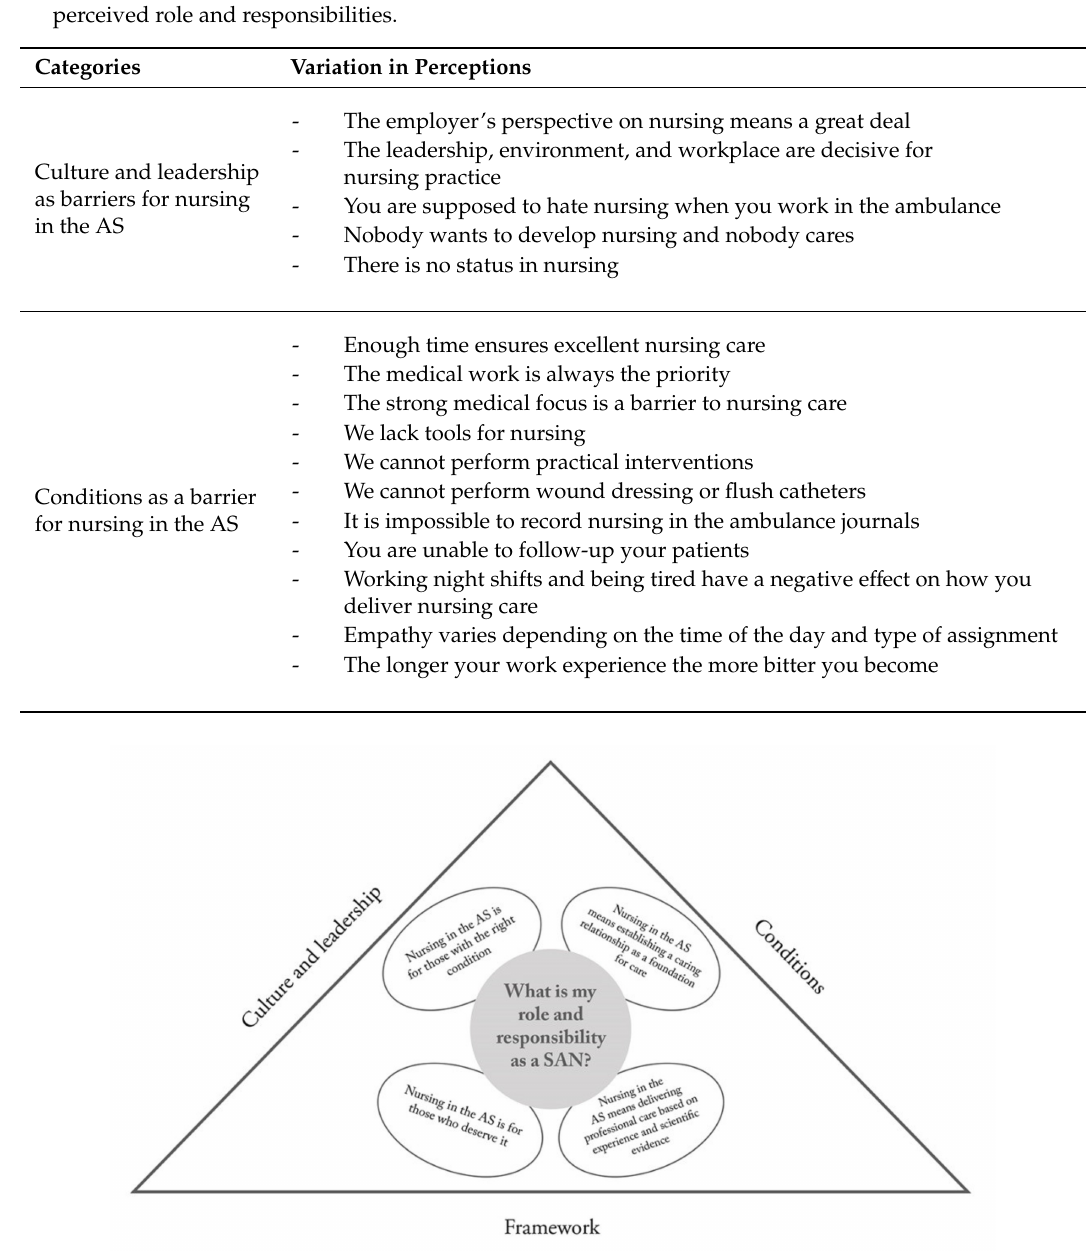
Figure 1. The outcome